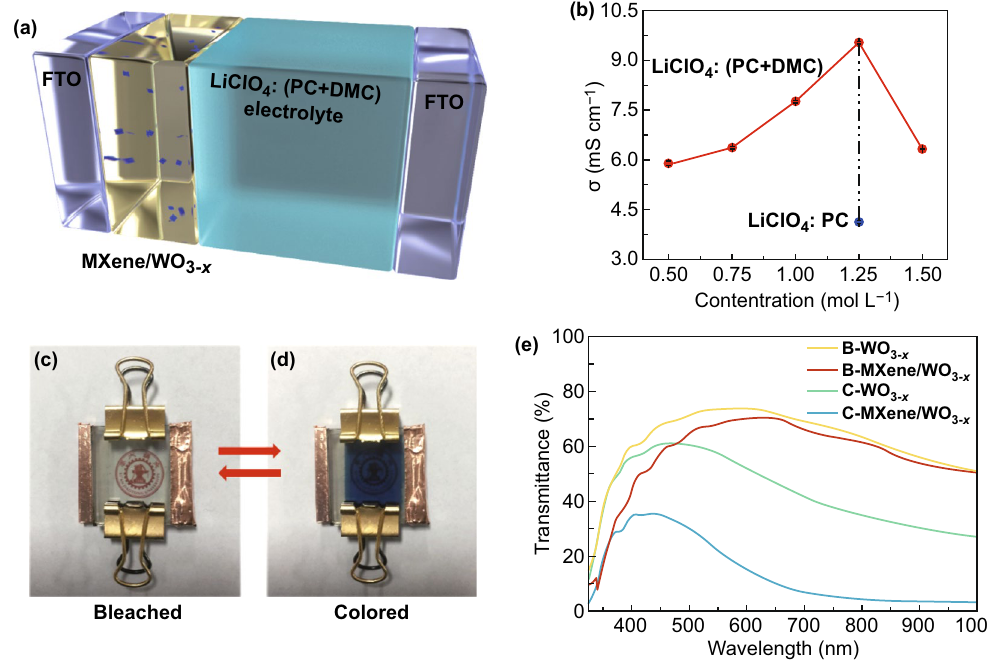
Fig. 2 a Schematic illustration of the electrochromic device based on the MXene/ WO 3− x film. b Conductivity of the electrolytes at room tem- perature with different LiClO 4 concentration. Digital photos of the electrochromic device based on the MXene/WO 3− x film in c colored state and d bleached state. e Transmittance spectra of pure WO 3− x and MXene/WO 3− x electrochromic devices in colored and bleached